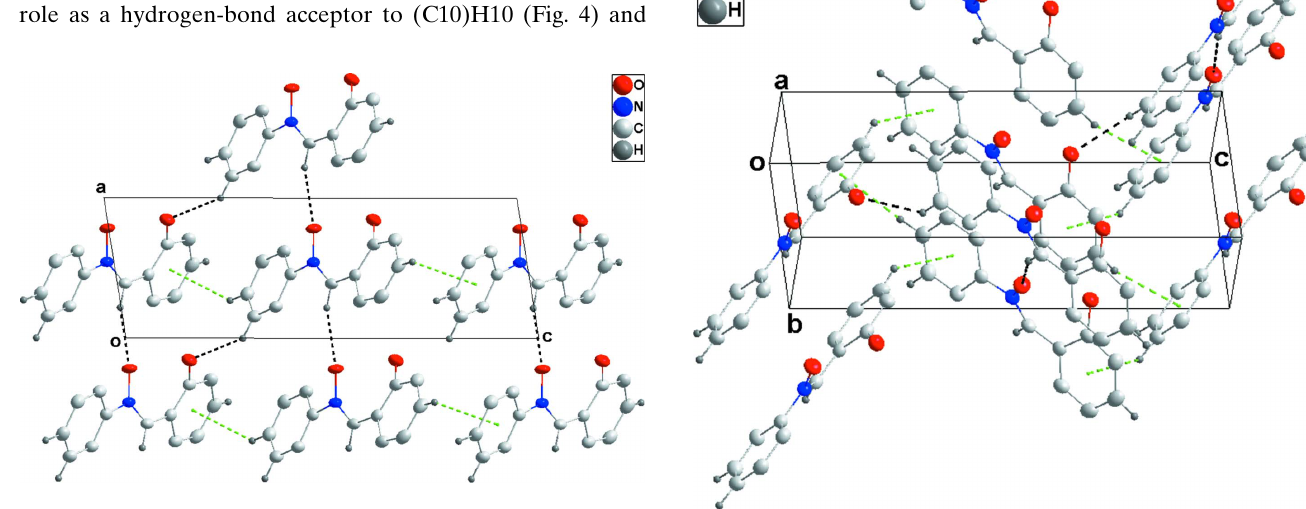
Figure 2 Detail of the intermolecular C—H (cid:2)(cid:2)(cid:2) O hydrogen bonds and the C— H (cid:2)(cid:2)(cid:2) (cid:2) (ring) interactions (black and green dashed lines, respectively) viewed along the b -axis direction.